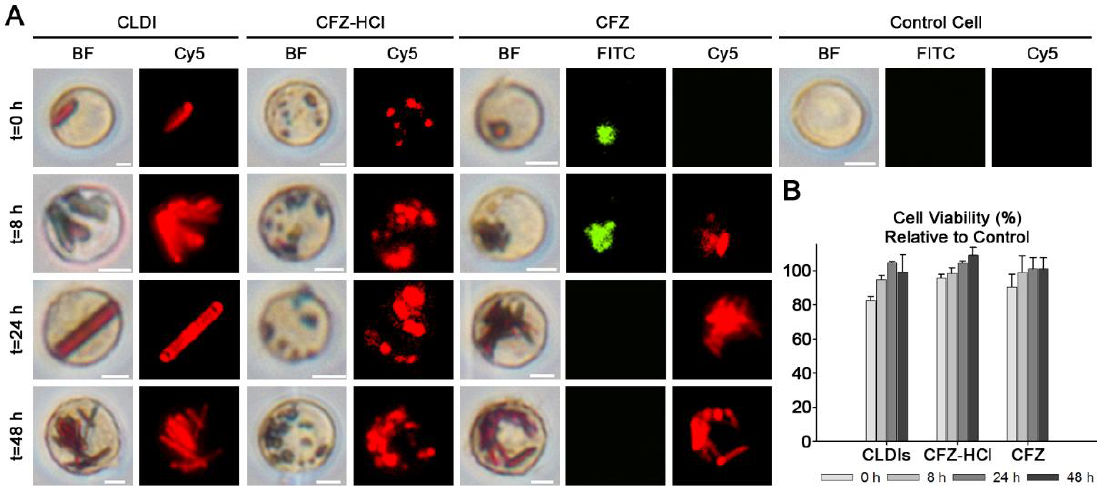
Figure 5. In vitro stability of the micronized CFZ-HCl salt and CFZ free base drug crystals in RAW 264.7 murine macrophages over 48 h compared to CLDIs, is depicted via brightfield and fluorescent images (FITC, Cy5) ( A ). Cell viability was not altered by 8, 24, and 48 h of treatment with CLDIs, CFZ-HCl, or CFZ free base ( B ).